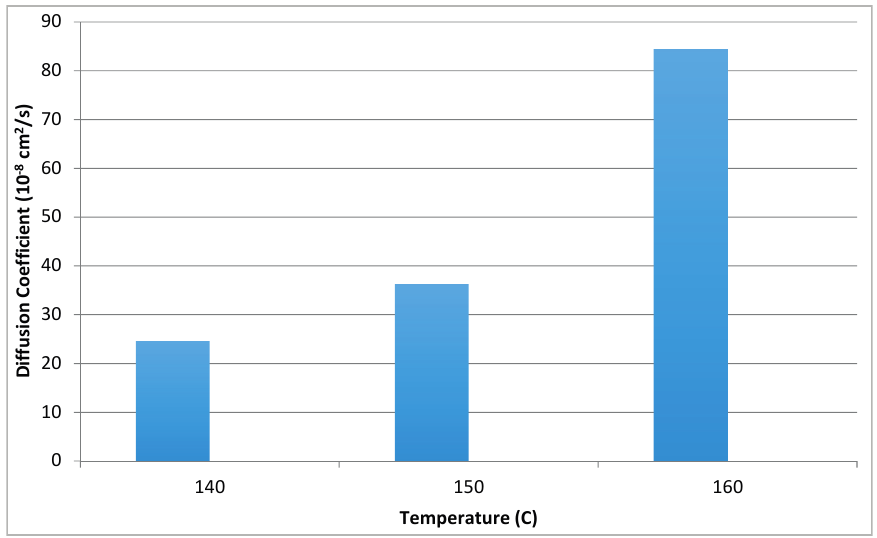
Figure 8. Diffusion coefficients at different